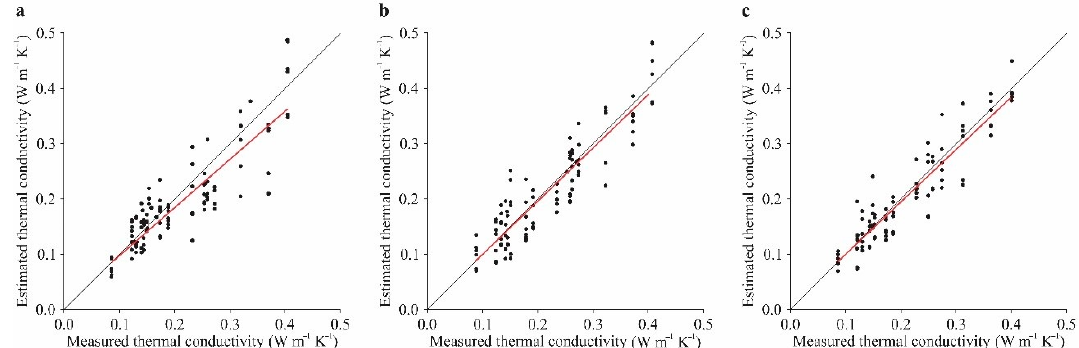
Figure 13. Estimated thermal conductivity ( k est , W m − 1 K − 1 ) of bed compost materials versus measured ( k mea , W m − 1 K − 1 )